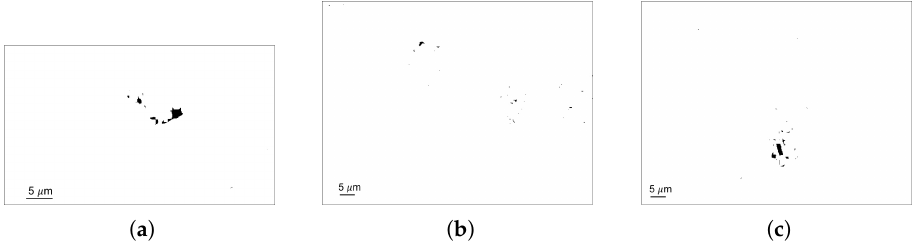
Figure 10. Result of floodfill algorithm applied to the dilated bright field images shown in Figure 9: